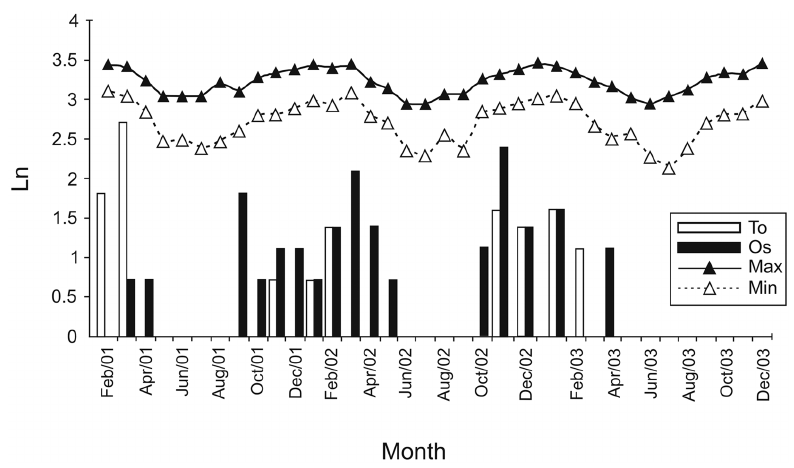
Fig. 5 – Capture incidence of two species versus temperature (minimum and maximum) for the studied area, municipality of Santa Maria, Rio Grande do Sul, Brazil. To = Teius oculatus ; Os = Ophiodes striatus ; Max = maximum temperature values; Min = minimum temperature values. The values were transformed into their natural logarithmic form